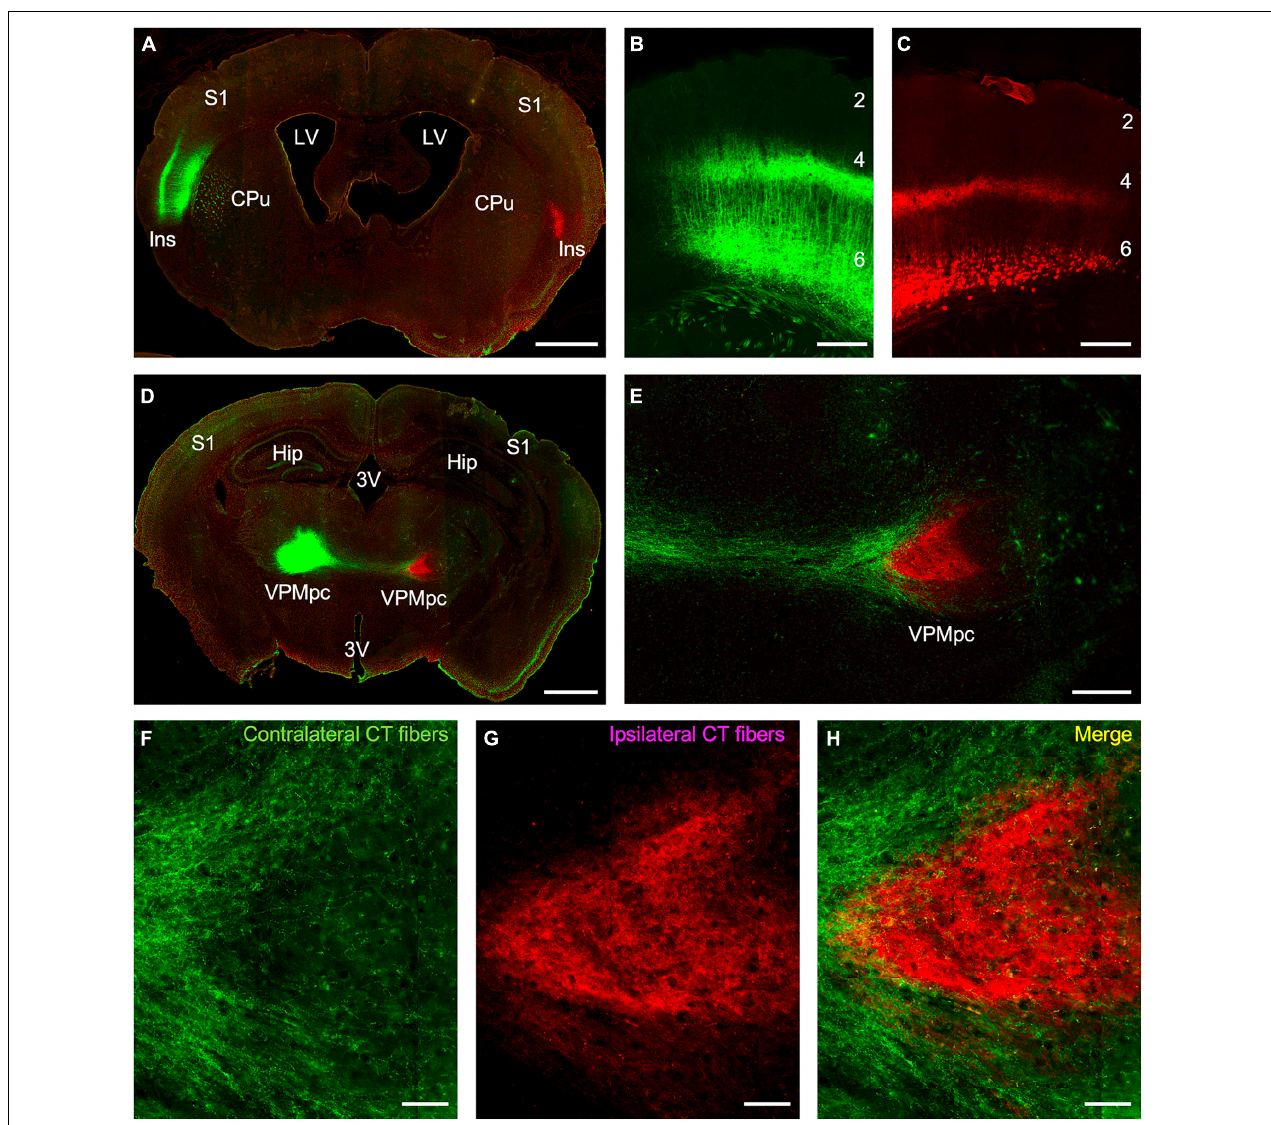
FIGURE 1 | Anterograde tracing of insular corticothalamic projections originating from layer 6 neurons in Ntsr1 Cre-recombinase expressing transgenic mice. (A) Injections of “floxed” AAV vectors expressing either EYFP (green) or mCherry (red) were stereotactically targeted to the left and right insular cortices, respectively. (B,C) Expression of virally encoded fluorescent proteins labeled the predicted population of layer 6 corticothalamic pyramidal neurons and their dendritic and axonal processes. (D) Anterograde fibers from both injections formed dense terminals in the respective ipsilateral thalamus, but also sent fibers to the contralateral thalamus. (E) Contralateral fibers (green fibers in this instance) crossed the midline and terminated in a region surrounding the ipsilateral fiber terminations (red fibers in this instance). (F–H) Despite the gross separation of terminal fields, some of the ipsilateral and contralateral corticothalamic (CT) labeling formed puncta in closely apposed regions, suggesting possible convergence of bilateral CT inputs on the same thalamic neuron. Abbreviations: CPu: caudate putamen; Hip: hippocampus; Ins: insular cortex; LV: lateral ventricle; S1: primary somatosensory cortex; VPMpc: parvicellular part of the ventral posteromedial nucleus; 3V: third ventricle; #s: layers 1–6. Scale bars: (A,D) : 1 mm; (B–C,E) : 250 µ m; (F–H) : 50 µ